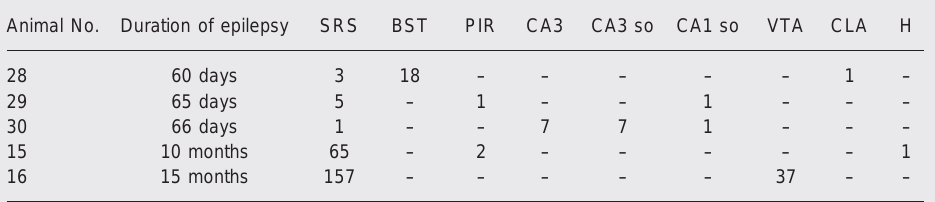
Table 2 . Number of silver-stained cells at selected septotemporal levels (see Methods) in chronic animals after spontaneous